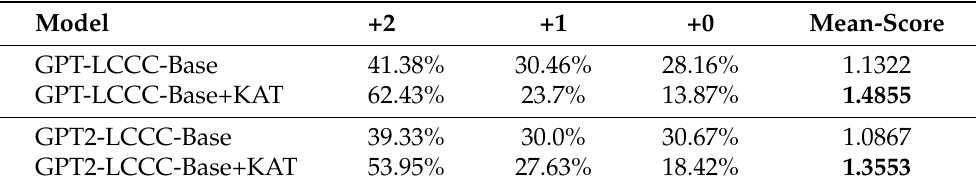
Table 3. Human Evaluation Results on Chinese Daily-Dialog Dataset. For each evaluation metric in every column, the best result is highlighted in boldface.